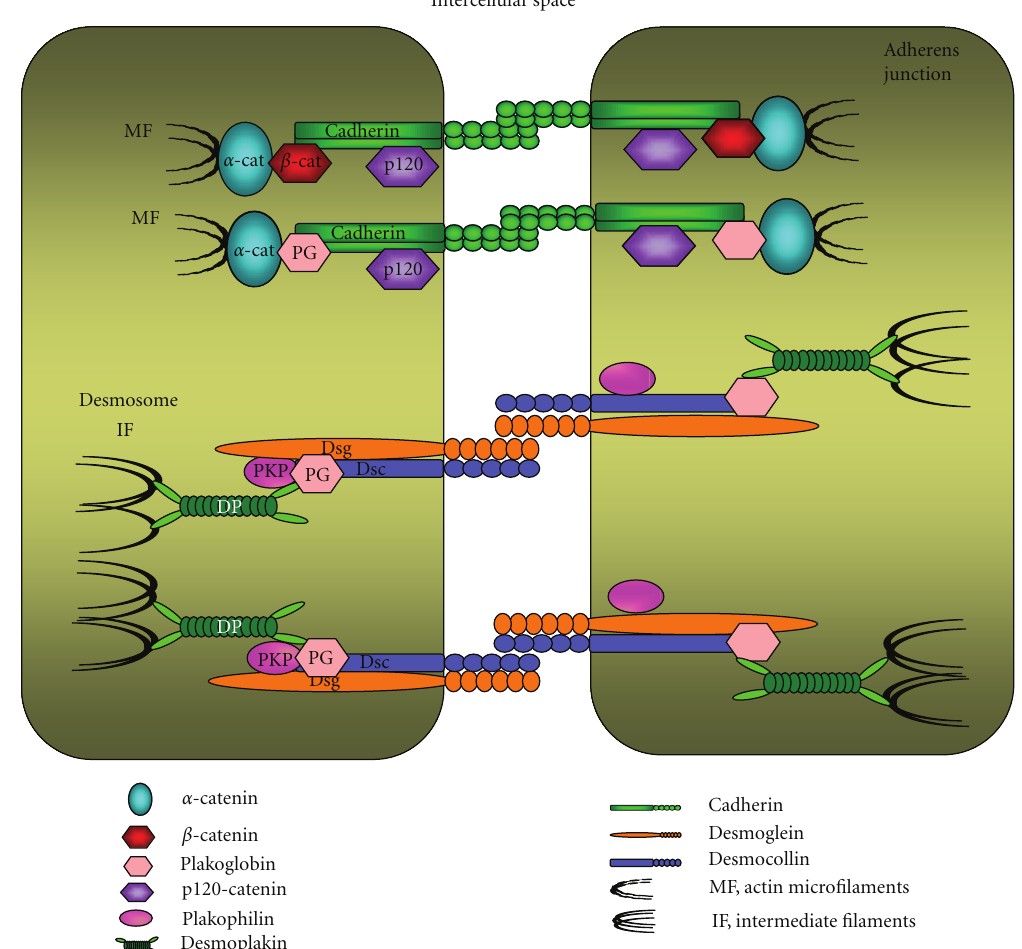
Figure 1: Cell adhesion complexes in epithelial cells. Cell-cell adhesion is maintained in epithelial tissues by the adherens junction and desmosomes. At the adherens junctions, E-cadherin forms extracellular interactions with E-cadherin molecules on neighboring cells. Intracellularly, E-cadherin interacts with either β -catenin or plakoglobin, which then interact with α -catenin, an actin-binding protein. A fourth catenin, p120-catenin, also interacts with E-cadherin and regulates its stability at the membrane. At the desmosome, the desmosomal cadherins (desmoglein and desmocollin) interact with plakoglobin and plakophilin, which interact with desmoplakin, which in turn associates with the intermediate filament cytoskeleton. The basic, core protein composition of the desmosomes is represented here: the exact protein constituents of the desmosomes and their interactions vary between di ff erent types of cells and